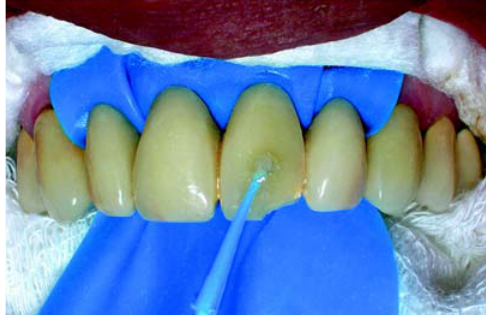
FIGURE 5- Application of the adhesive system